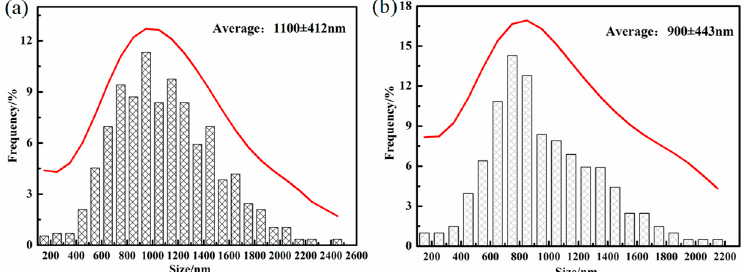
Figure 5. Size distribution of the blocky retained austenite in different samples after isothermally transformed at 300 °C for 4 h. ( a ) DIT sample; ( b ) QBT-12 sample.